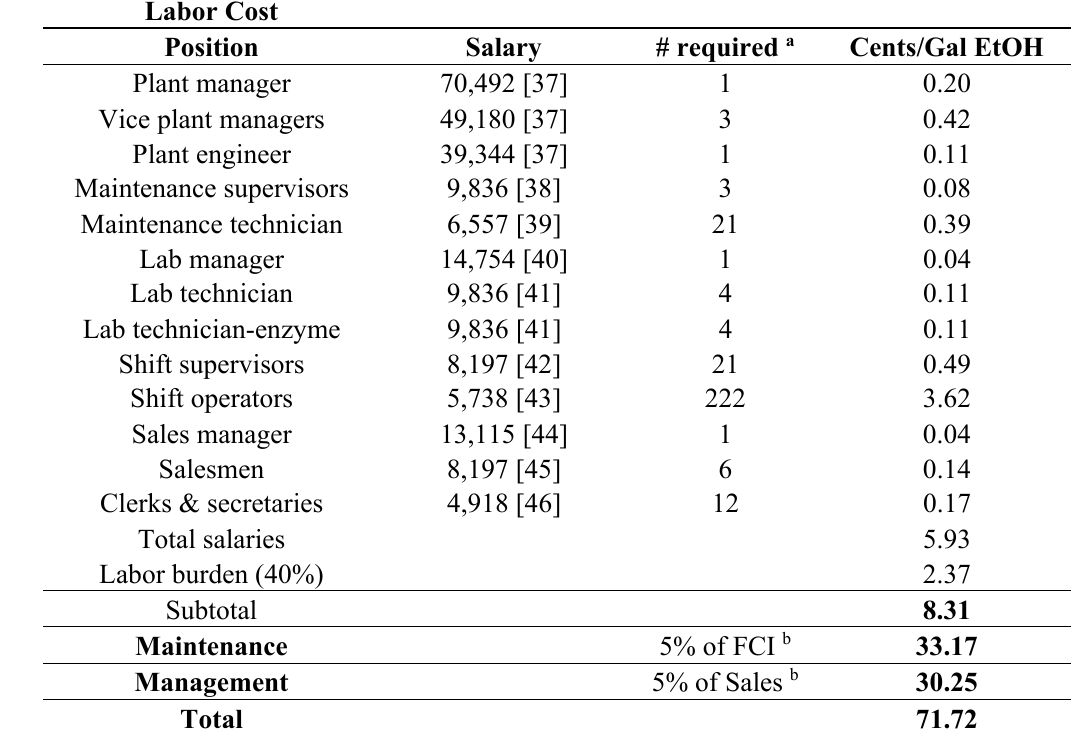
Table 11. Annual fixed operating cost (Scenario